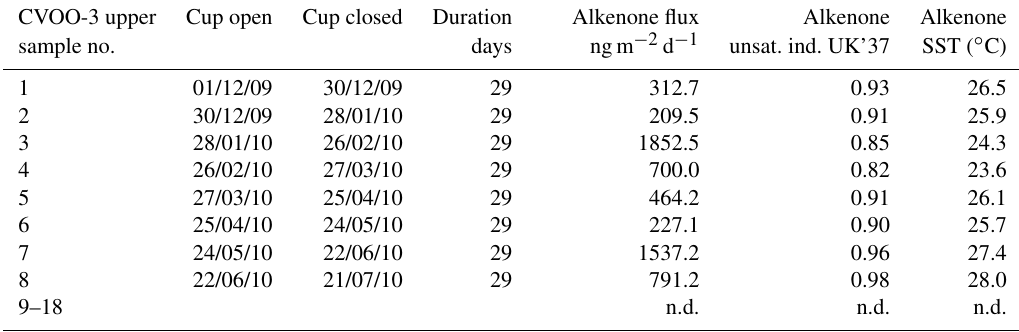
Table 3. Fluxes of alkenones, the U k